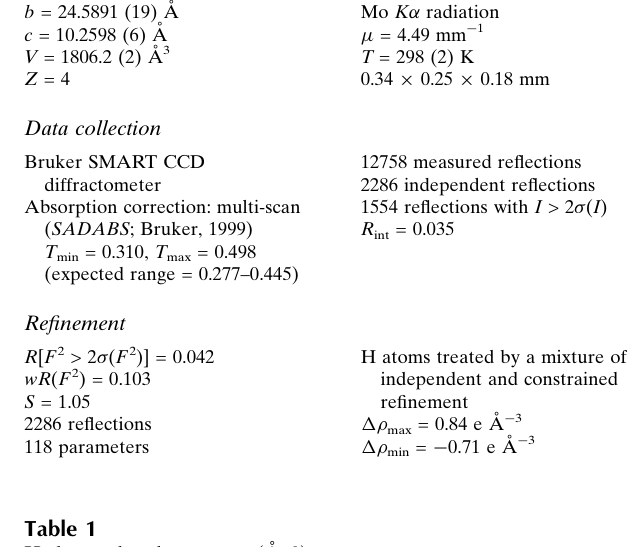
Hydrogen-bond geometry (A˚ , (cid:1)